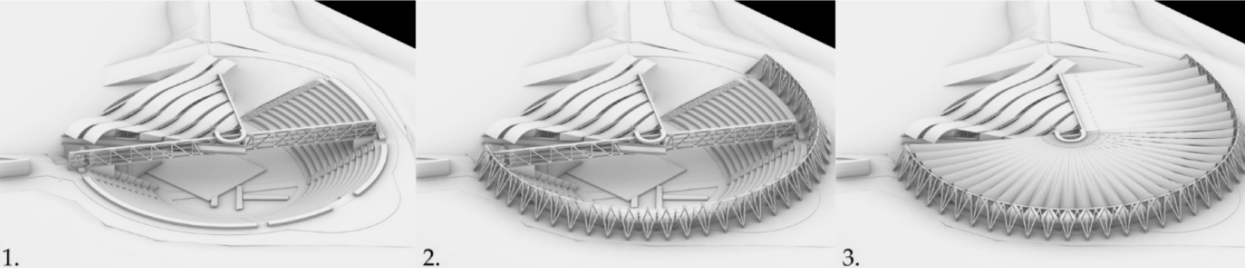
Figure 11. Stages of the conversion of the amphitheater into the odeon in Biała Podlaska. ( 1 ) Existing amphitheater with roof over the stage. ( 2 ) New steel space truss on the crown of the fortification ramparts. ( 3 ) New membrane roof with tensioned surface forming cables. Author graphics based on source BP